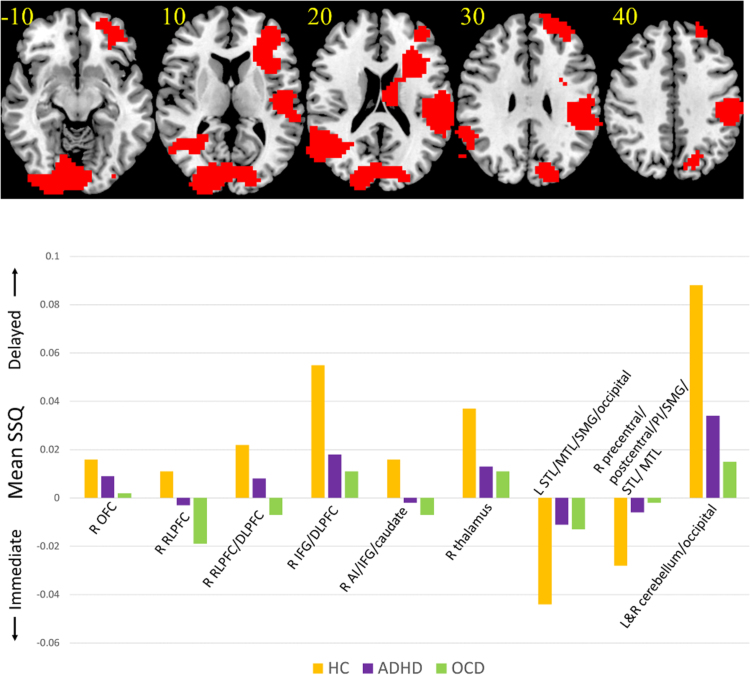
ANCOVA results for the between-group differences in brain activation for contrast comparing delayed and immediate choices. (A) Axial slices for the group activation maps for the three groups with a voxel threshold of p<0.05 and a cluster threshold of p<0.027. Red indicates significant between-group differences in activation for the delayed versus immediate choice contrast. Talairach z-coordinates are indicated for slice distance (in mm) from the intercommissural line. The right side of the brain corresponds to the right side of the image. (B) Bar chart showing mean SSQ for each group in each cluster. Controls = orange, ADHD = purple, OCD = green.